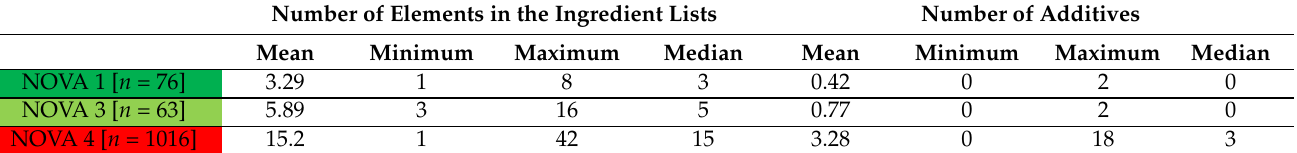
Table 6. Number of elements and number of additives in the list of ingredients by degree of processing as defined in the NOVA classification ( n = 1155).